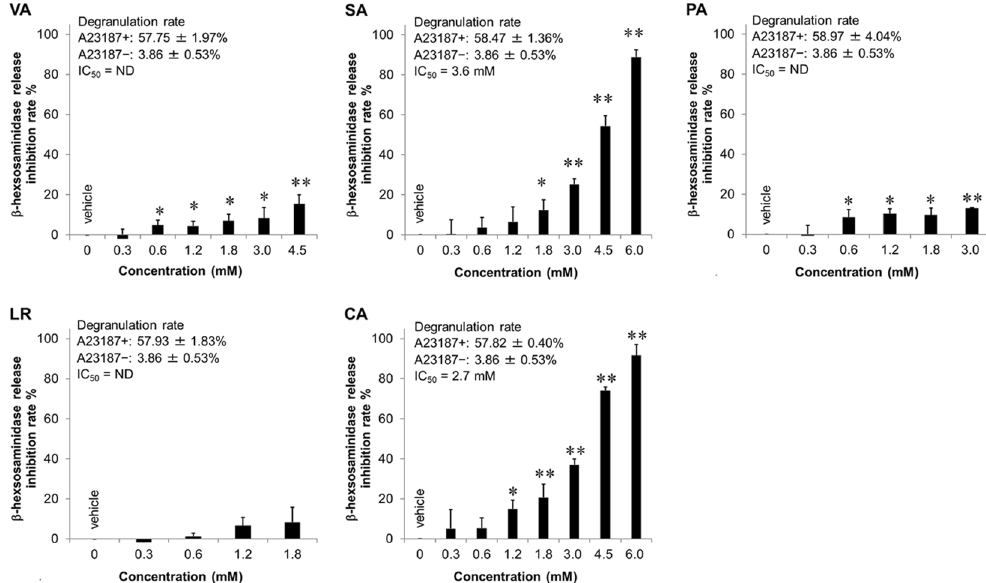
Figure 8. Inhibitory effects of active compounds derived from ume on non-IgE-mediated degranulation of RBL-2H3 cells. RBL-2H3 cells were stimulated with A23187 in the presence or absence of ume seed extracts. Data represent the mean ± SD (n = 3) of β -hexosaminidase release inhibition rate of three independent experiments. Degranulation rates of maximum response when cells are treated with vehicle and A23187 (A23187 + ) or minimum response when cells are treated with vehicle alone (A23187-) and IC 50 are shown in the figures. ND: not determined. * p < 0.05, ** p < 0.001, compared with